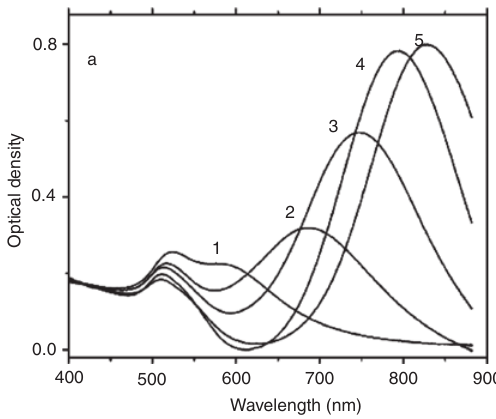
Figure 9: Visible spectra of five identical growth solutions in which the silver content increases from sample no. 1–5. By controlling the Ag ion concentration, the length of the nanorods can be adjusted. Adapted with permission from Ref. [78]. Copyright (2015) American Chemical Society.